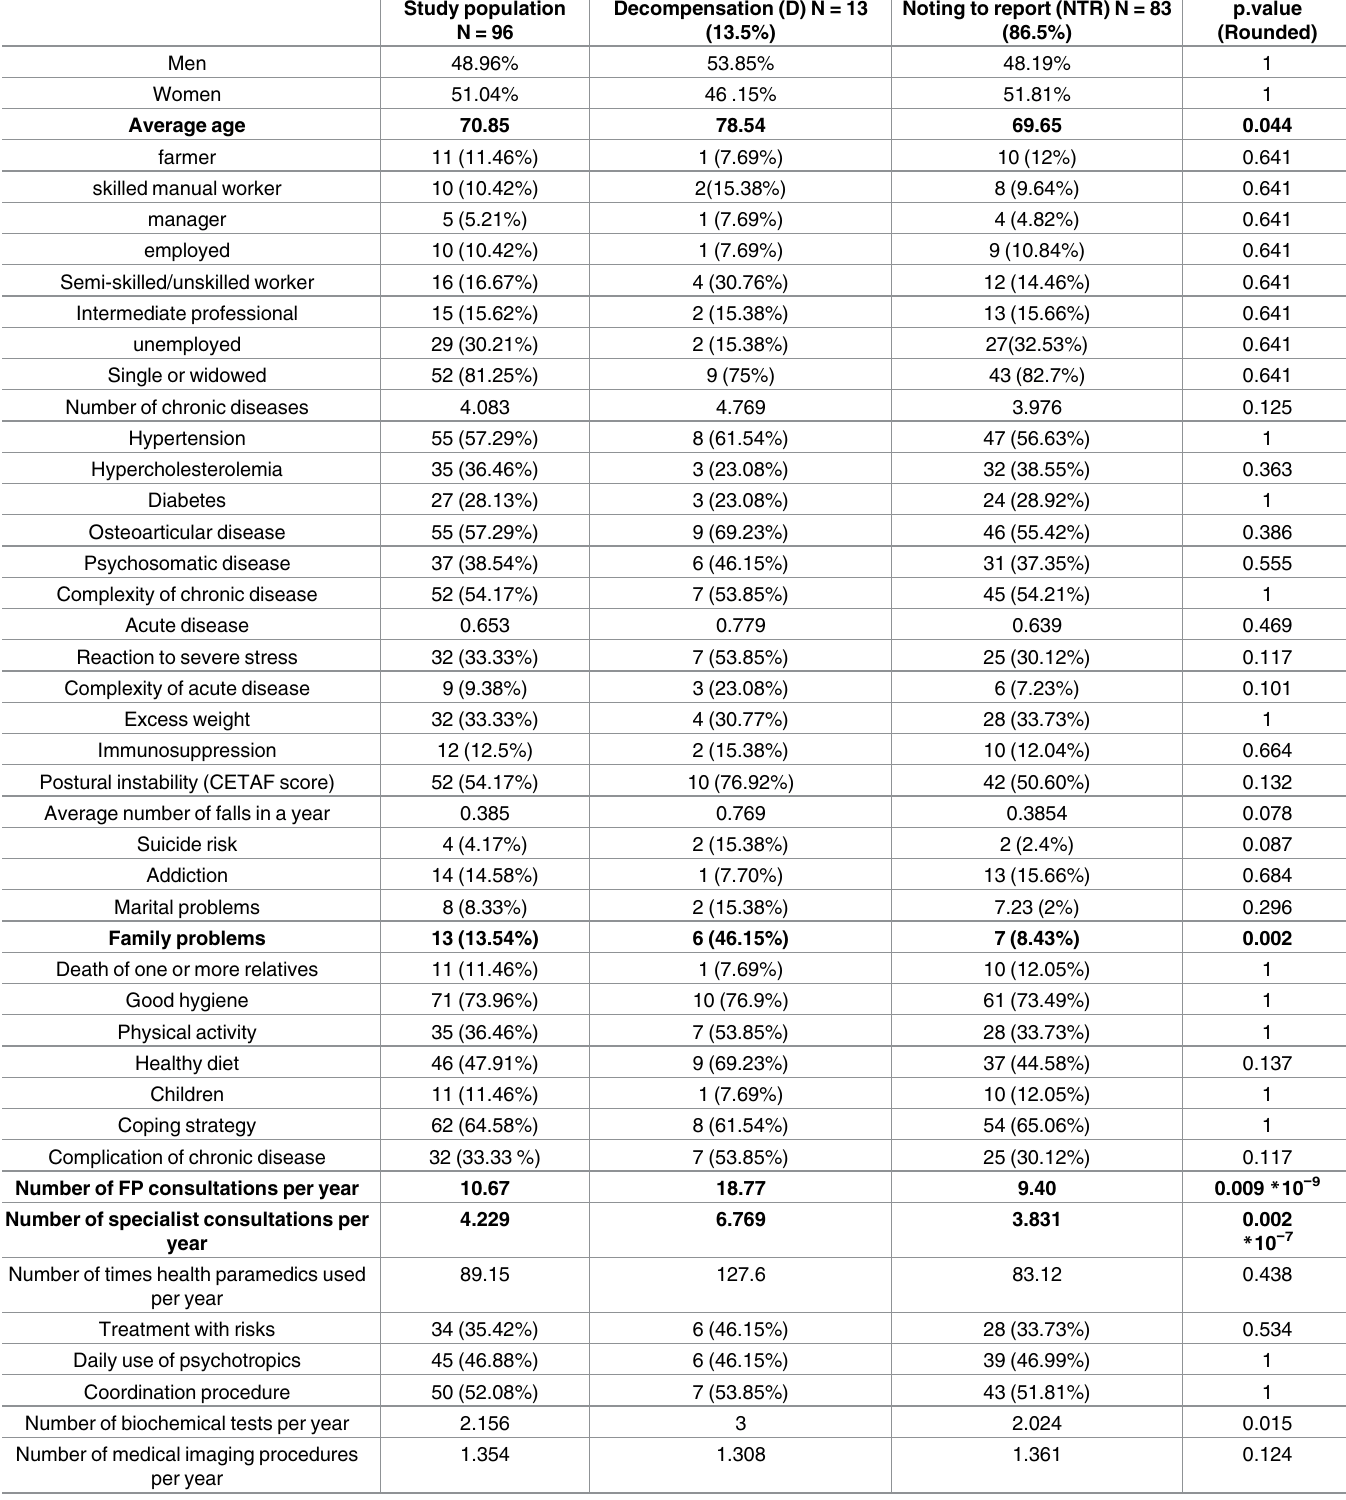
Table 2. Characteristics of D group and NTR group for each variable as described by the